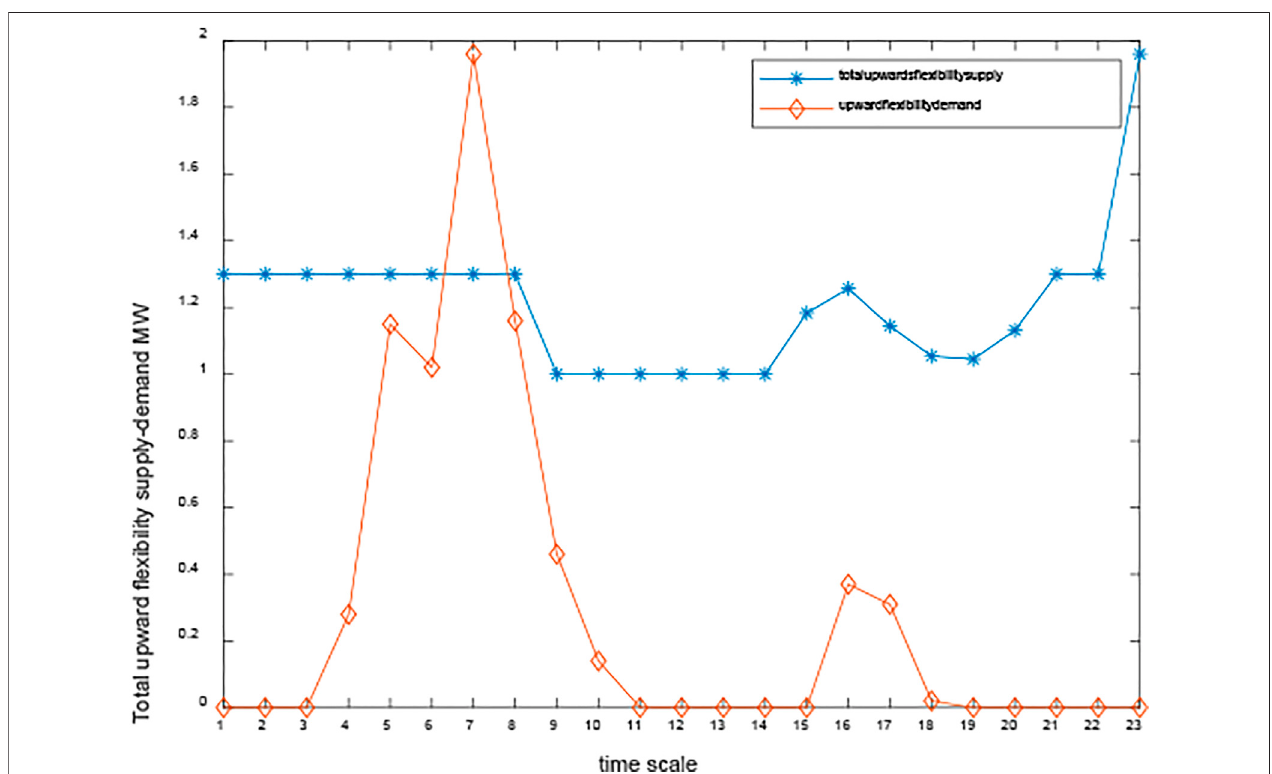
FIGURE 13 | Total upward fl exibility supply – demand of case